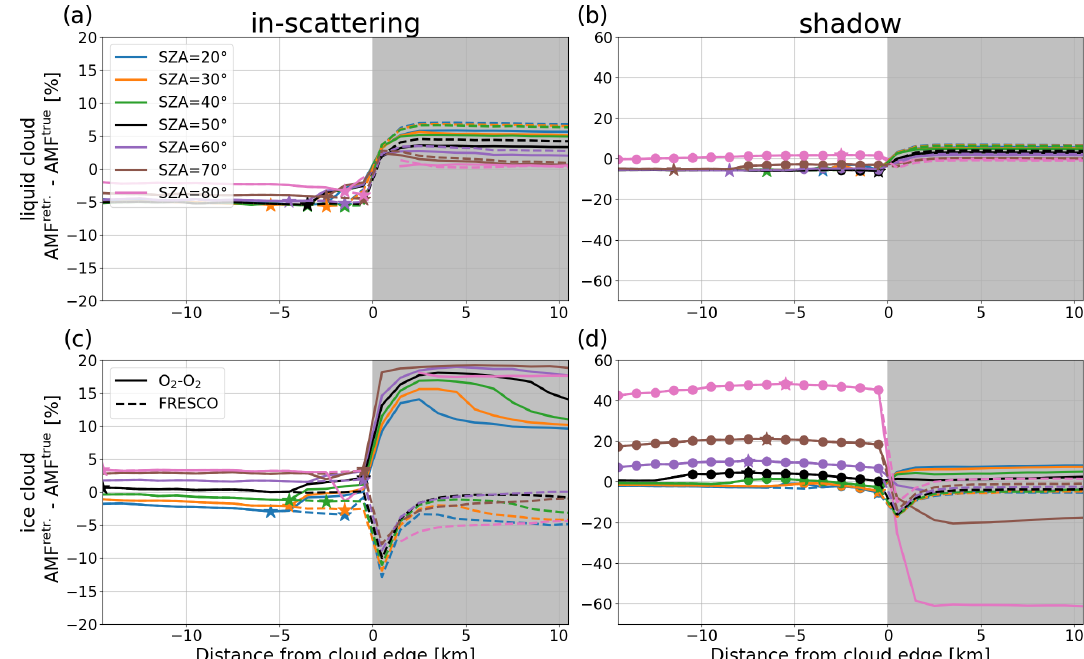
Figure A2. Similar to Fig. 3 but the AMF retrieval using the clean NO 2 profile.